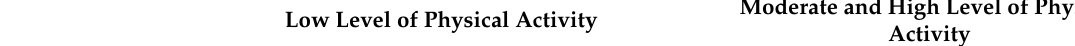
Table 6. Association of the MC4R rs17782313 polymorphism with anthropometric measurements by the level of physical activity in